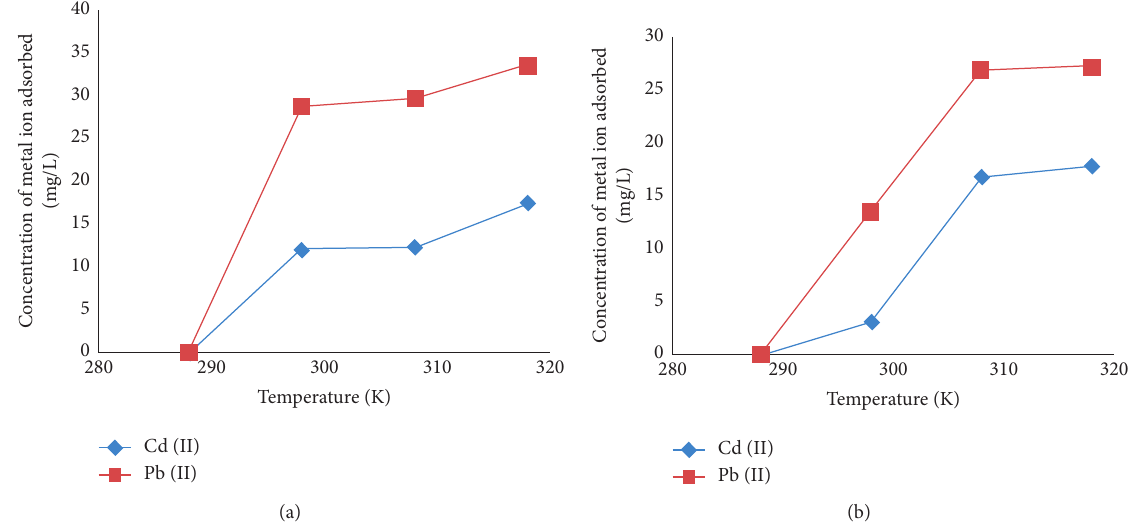
Figure 7: Effect of solution temperature on the amount of metal ion adsorbed for clay-1 (a) and clay-2 (b).